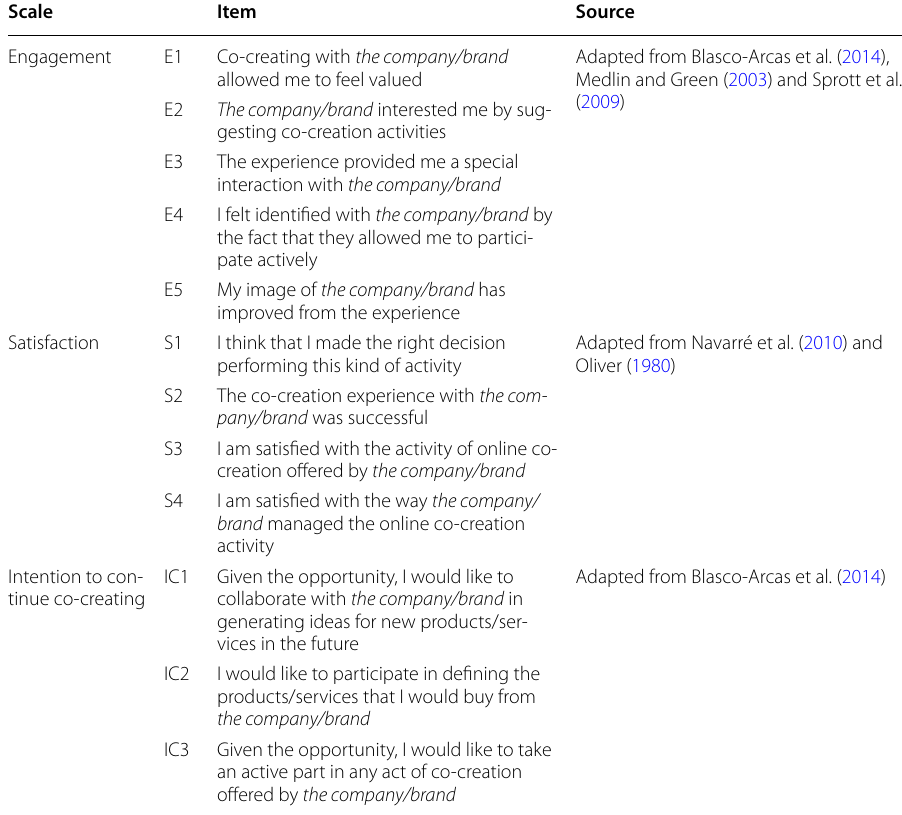
Words in italics are those that in the online questionnaire were changed as per the chosen retailer with whom they co‑created most